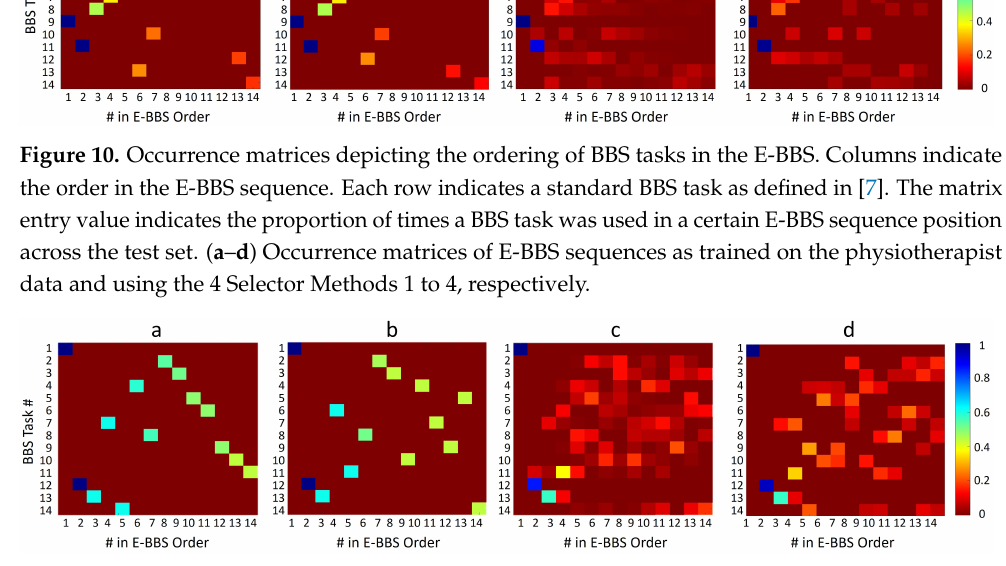
Figure 11. ( a – d ) same as Figure 10, but trained on the automatic BBS scoring data.